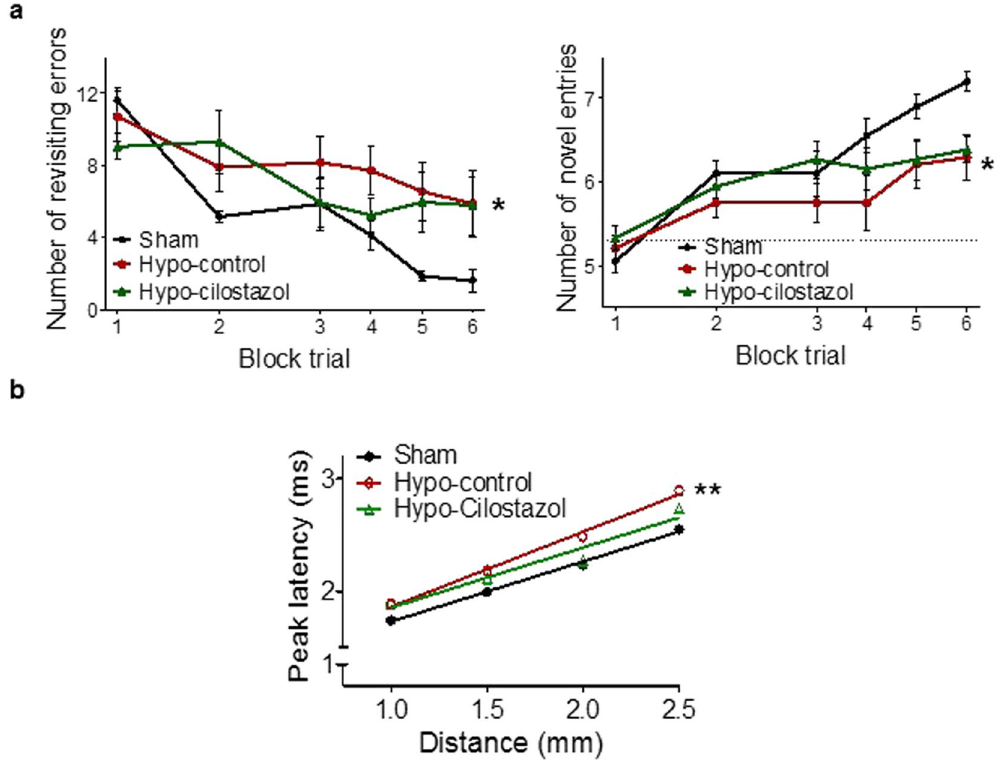
Figure 1. Cilostazol improved spatial working memory and white matter function: ( a ) Spatial working memory was assessed using an 8-arm radial arm maze. Statistical analysis of the number of revisiting errors and novel entries indicated an overall significant difference between the 3 groups ( F (2, 34) = 5.169; p = 0.029 and F (2, = 5.718; p = 0.022, respectively). Hypoperfused-control mice exhibited significantly more revisiting errors 34) and less novel entries than the sham operated mice ( p < 0.05 and p < 0.05), while hypoperfused-cilostazol mice showed a learning process similar to that of sham mice before they plateaued. Data represents the average of 4 trials for block 1 and 2 and the average of 2 trials for blocks 3–6. ( b ) In the corpus callosum, evoked compound actions potentials (CAPs) were recorded at various distances from the stimulating electrode. Peak latencies of CAPs were significantly different between the three groups ( F (2,12) = 14.78; p = 0.0048). The peak latency of CAPs in hypoperfused-control mice was overall significantly increased compared to sham mice ( p < 0.01) but this was ameliorated with cilostazol treatment. Data represents mean ± SEM. ** p < 0.01, Hypoperfused-control vs